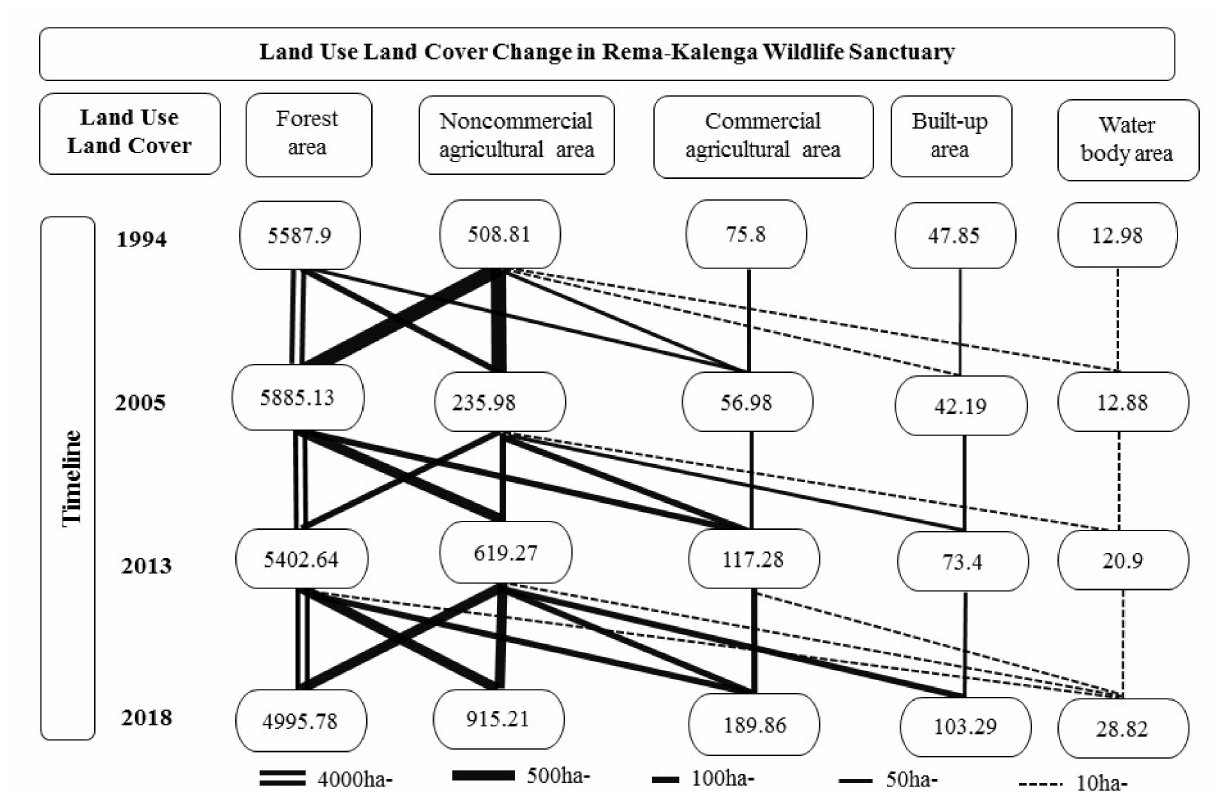
Figure 5. Transitions among forest land use types and the extent of each land use type from 1994 to 2018. Changes larger than 10 ha are described. The size of the circle corresponds to the area for each land use type, and the width of the lines between circles represents the area of conversion. Large areas of forest and agricultural lands were converted to each other between 1994 and 2005, 2005 and 2013, and 2013 and 2018 in the study area. After 2013, there was an increase in conversion from forest land to land for commercial uses, such as crop